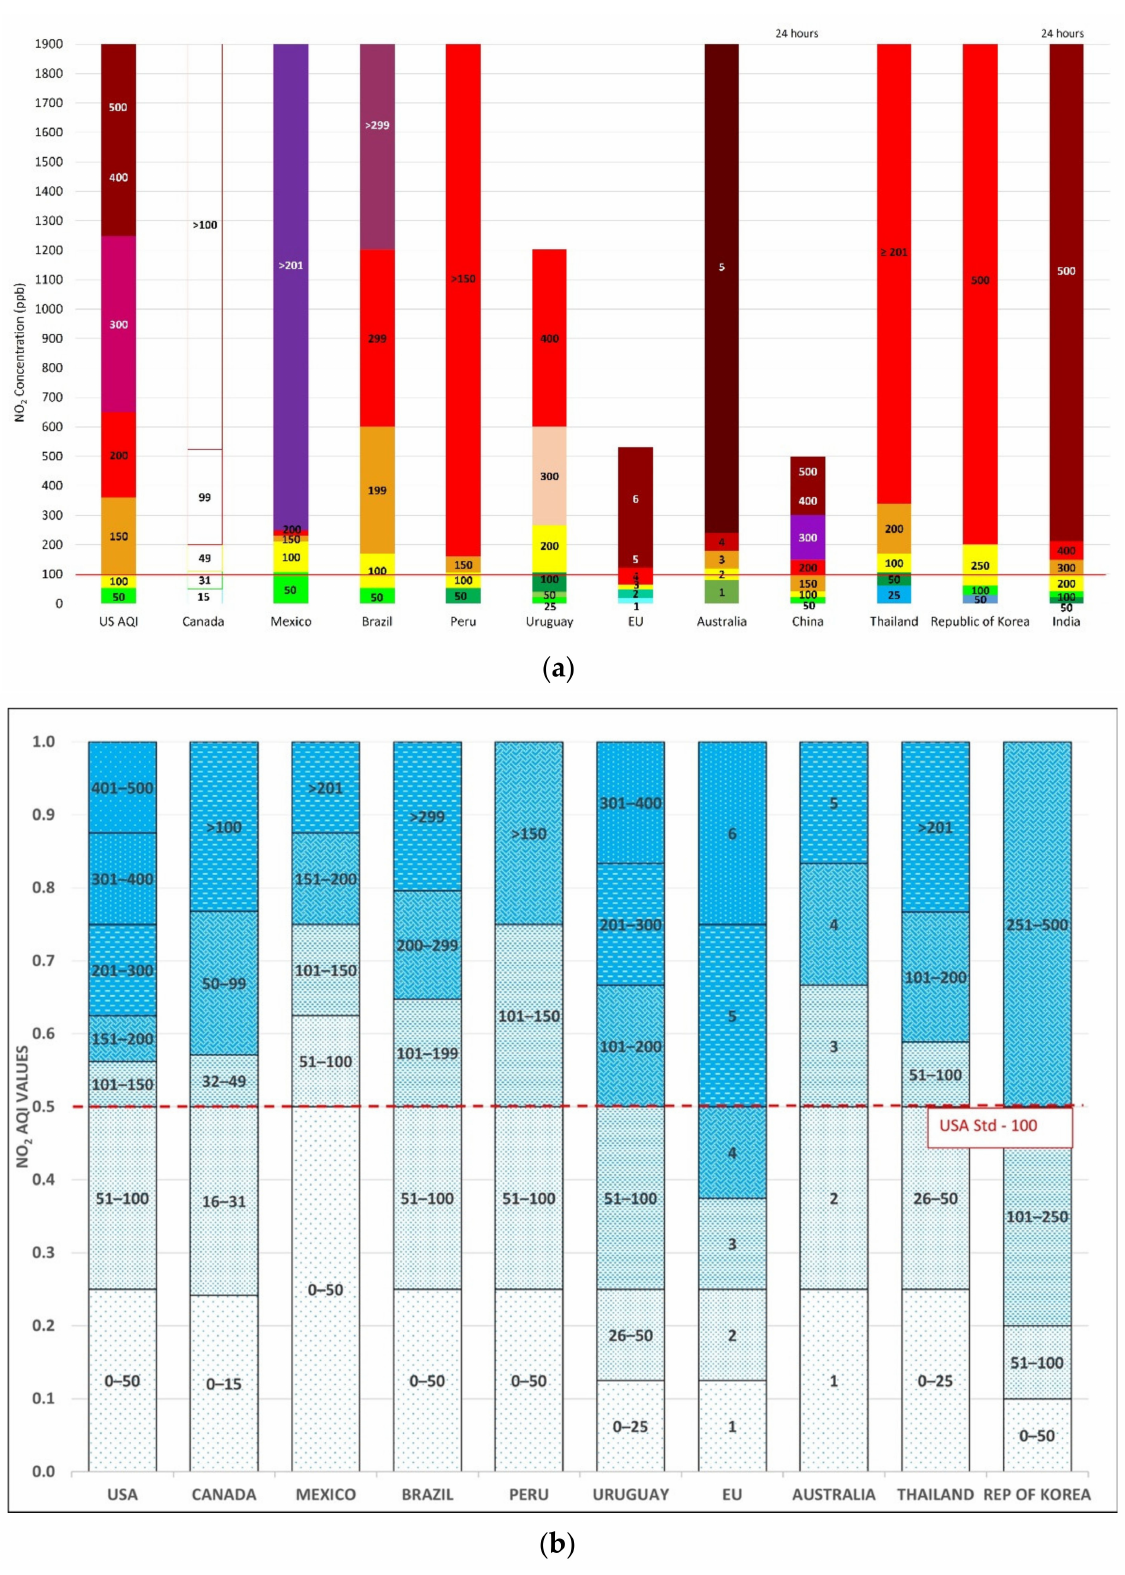
Figure 1. ( a ) NO 2 concentration corresponding to AQI classes in different countries (on 1 h basis, except for China and India, which averaged over 24 h). The red line represents the USA standard. ( b ). Normalized NO 2 AQI values (based on 1-h averaged